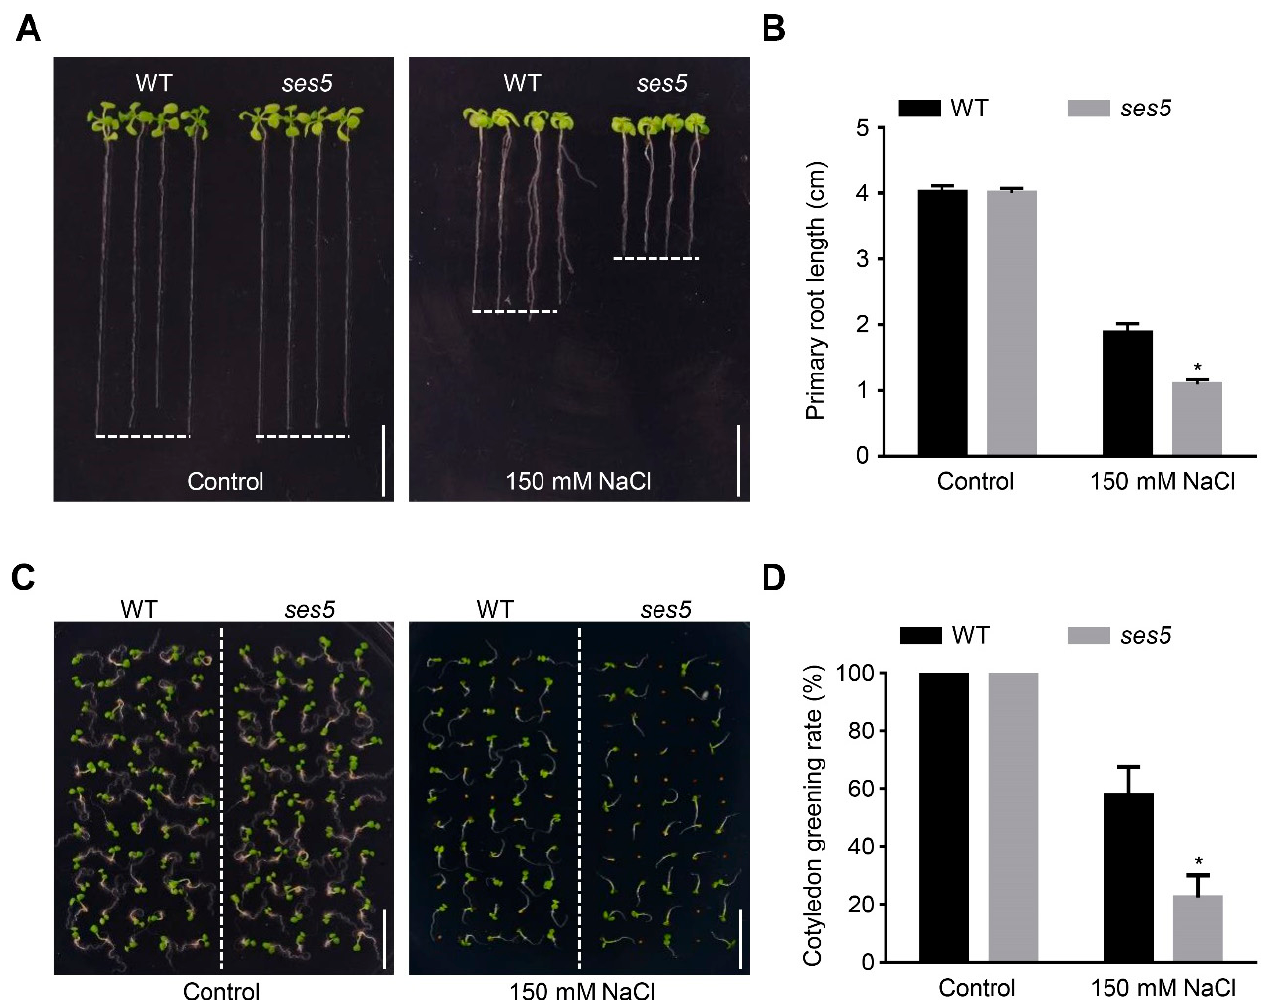
Figure 1. The ses5 mutant is sensitive to salt stress. ( A ) Photographs of WT and ses5 seedlings grown vertically on control or salt-containing medium. Three-day-old WT and ses5 seedlings grown on 1/2 MS medium were transferred to 1/2 MS medium with or without 150 mM NaCl for another 10 d. Scale bar = 1 cm. ( B ) Primary-root length of the seedlings in ( A ). ( C ) Photographs of 7-day-old WT and ses5 seedlings grown horizontally on 1/2 MS medium with or without 150 mM NaCl. Scale bar = 1 cm. ( D ) Cotyledon-greening rate of the seedlings in ( C ). The bars indicate means ± sd of three independent replicates. * p < 0.05 (Student’s t test).